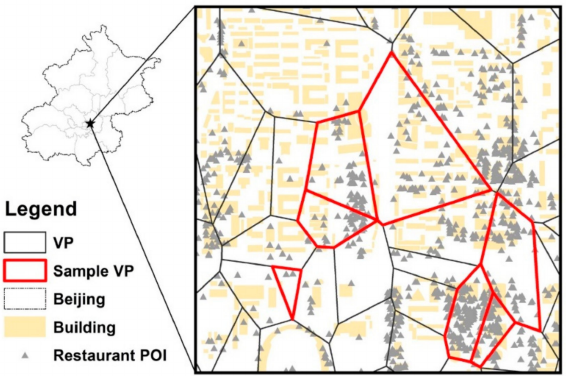
Figure A4. Restaurants Community (RC) example for the Sanlitun area of Beijing.